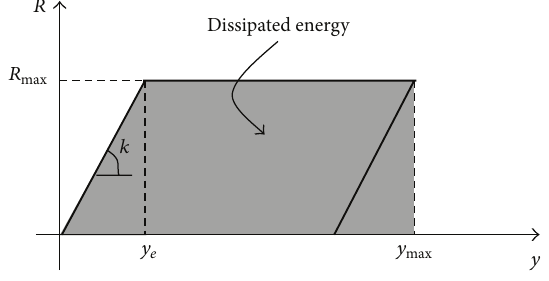
Figure 8: The idealized elastic-plastic response function